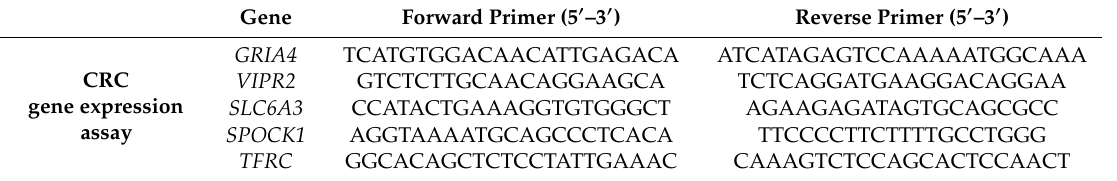
Table 5. Primers for quantitative real-time polymerase chain reaction (qRT-PCR) assay.